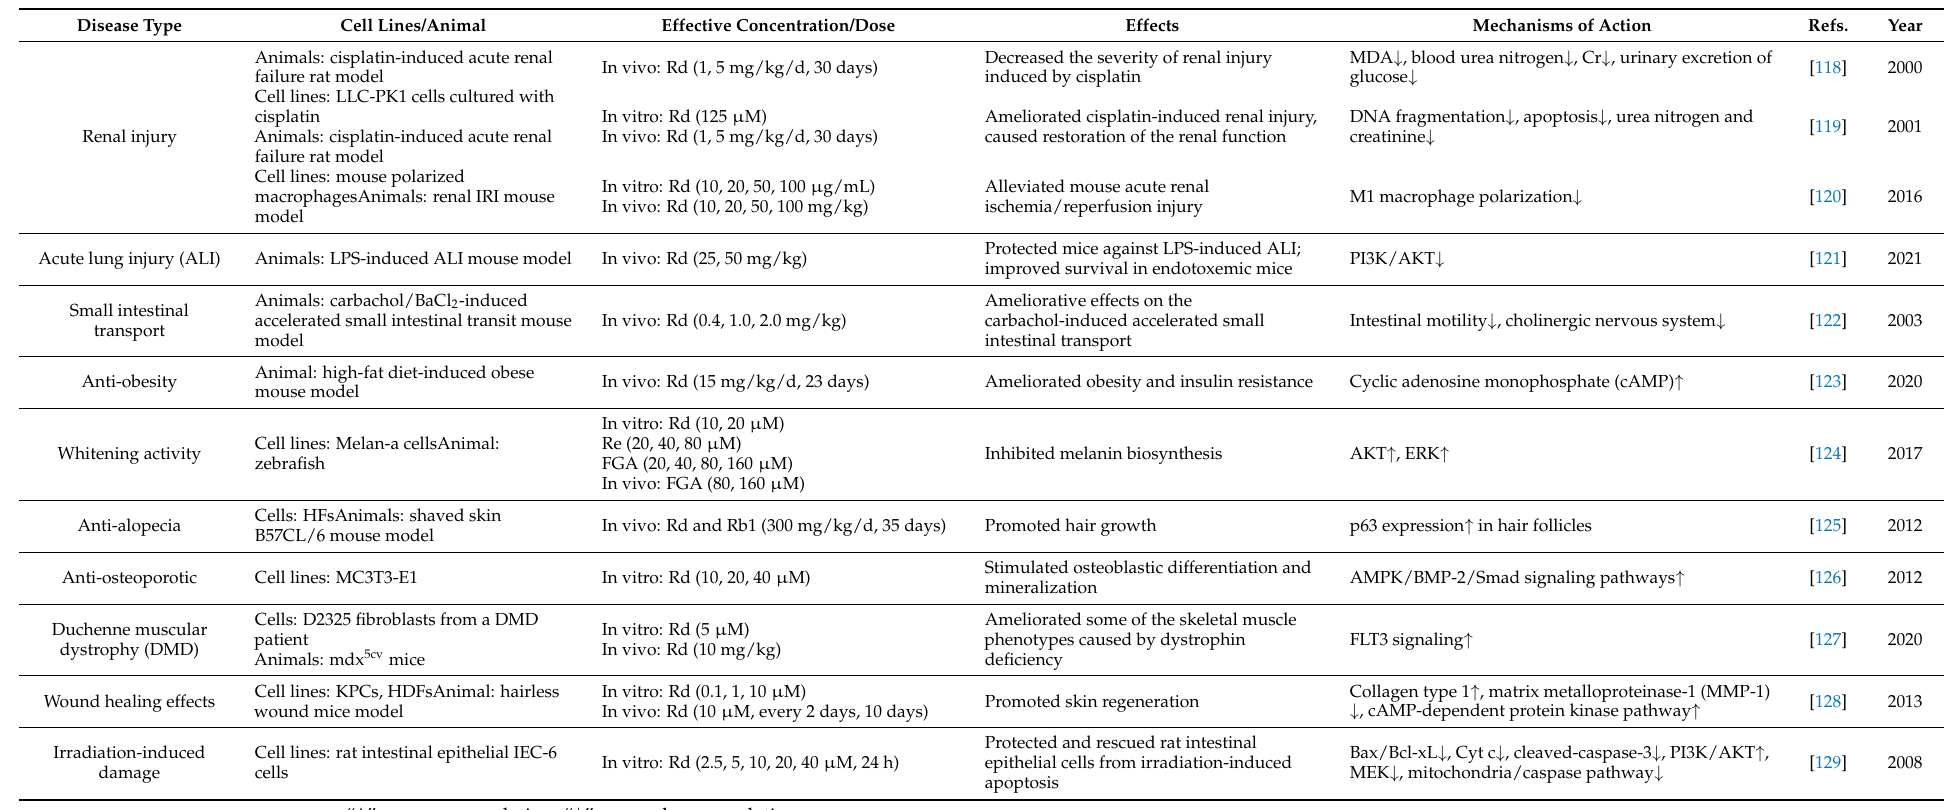
Table 6. Other health-beneficial activities and the molecular mechanisms of